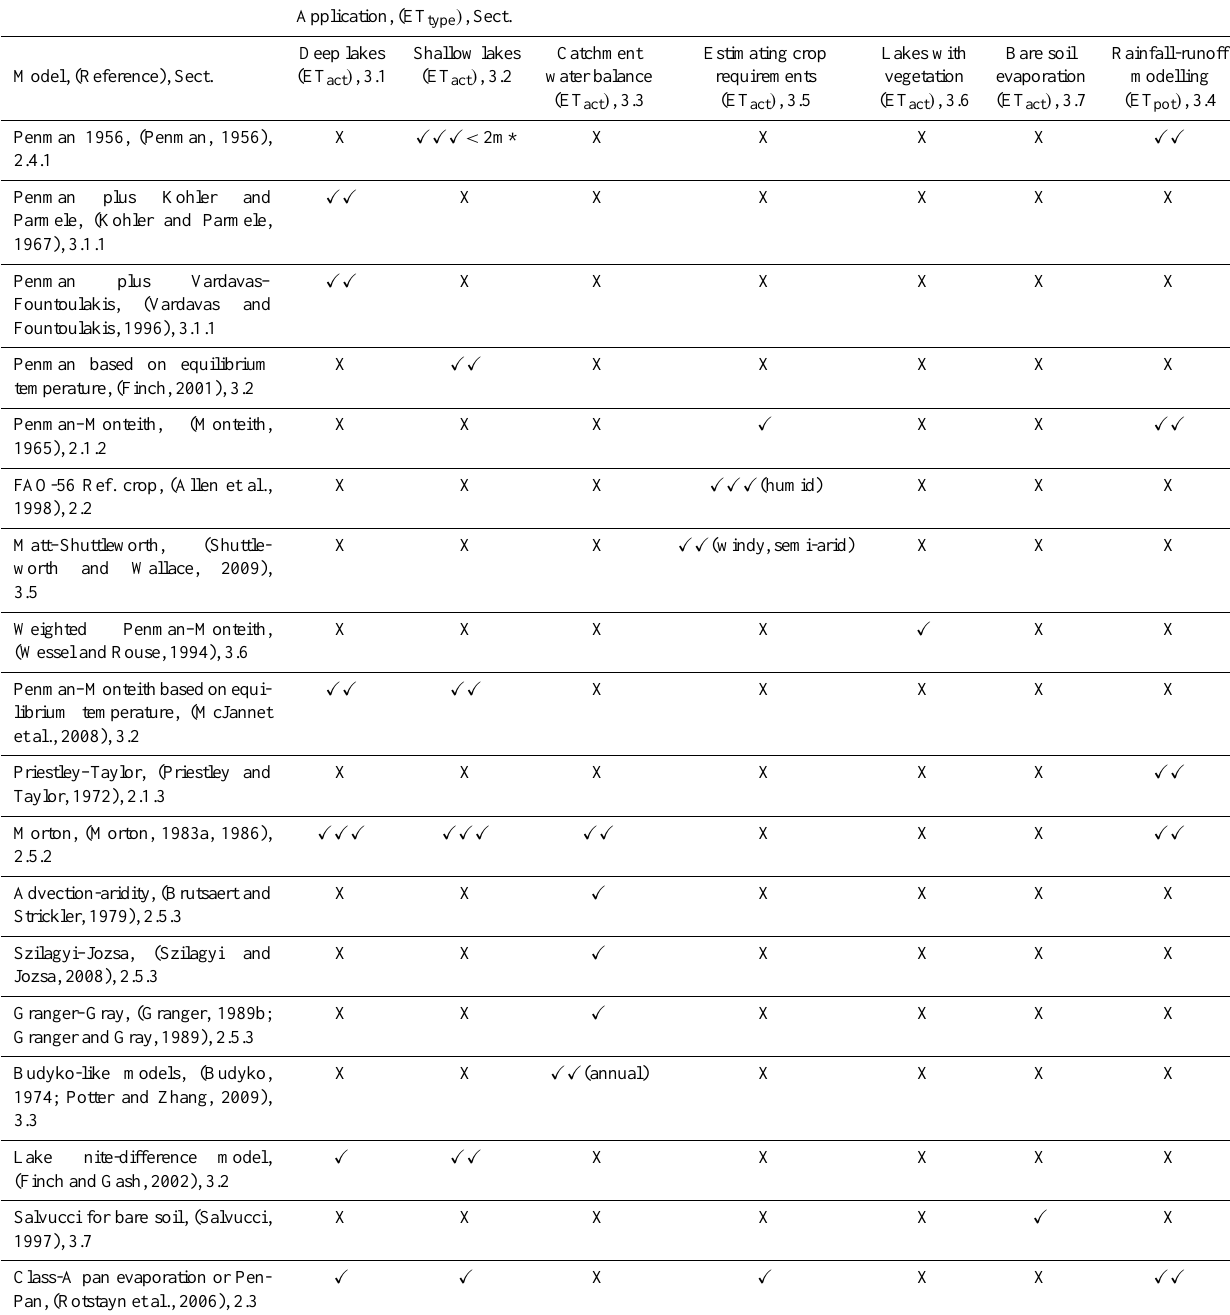
Table 4. Practical application in estimating monthly evaporation (This summary is based on models described in the paper and Supplement except those techniques that are discussed in Sect. S9). XXX preferred; XX acceptable; X not preferred or insufficient field testing; X not